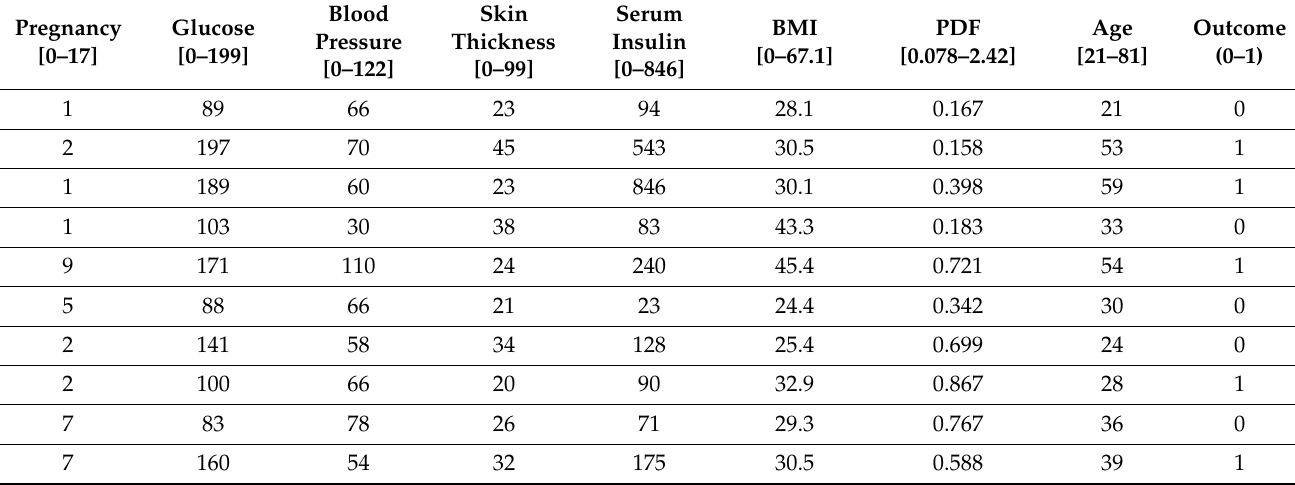
Table 1. Some examples of Pima Indians Diabetes dataset.